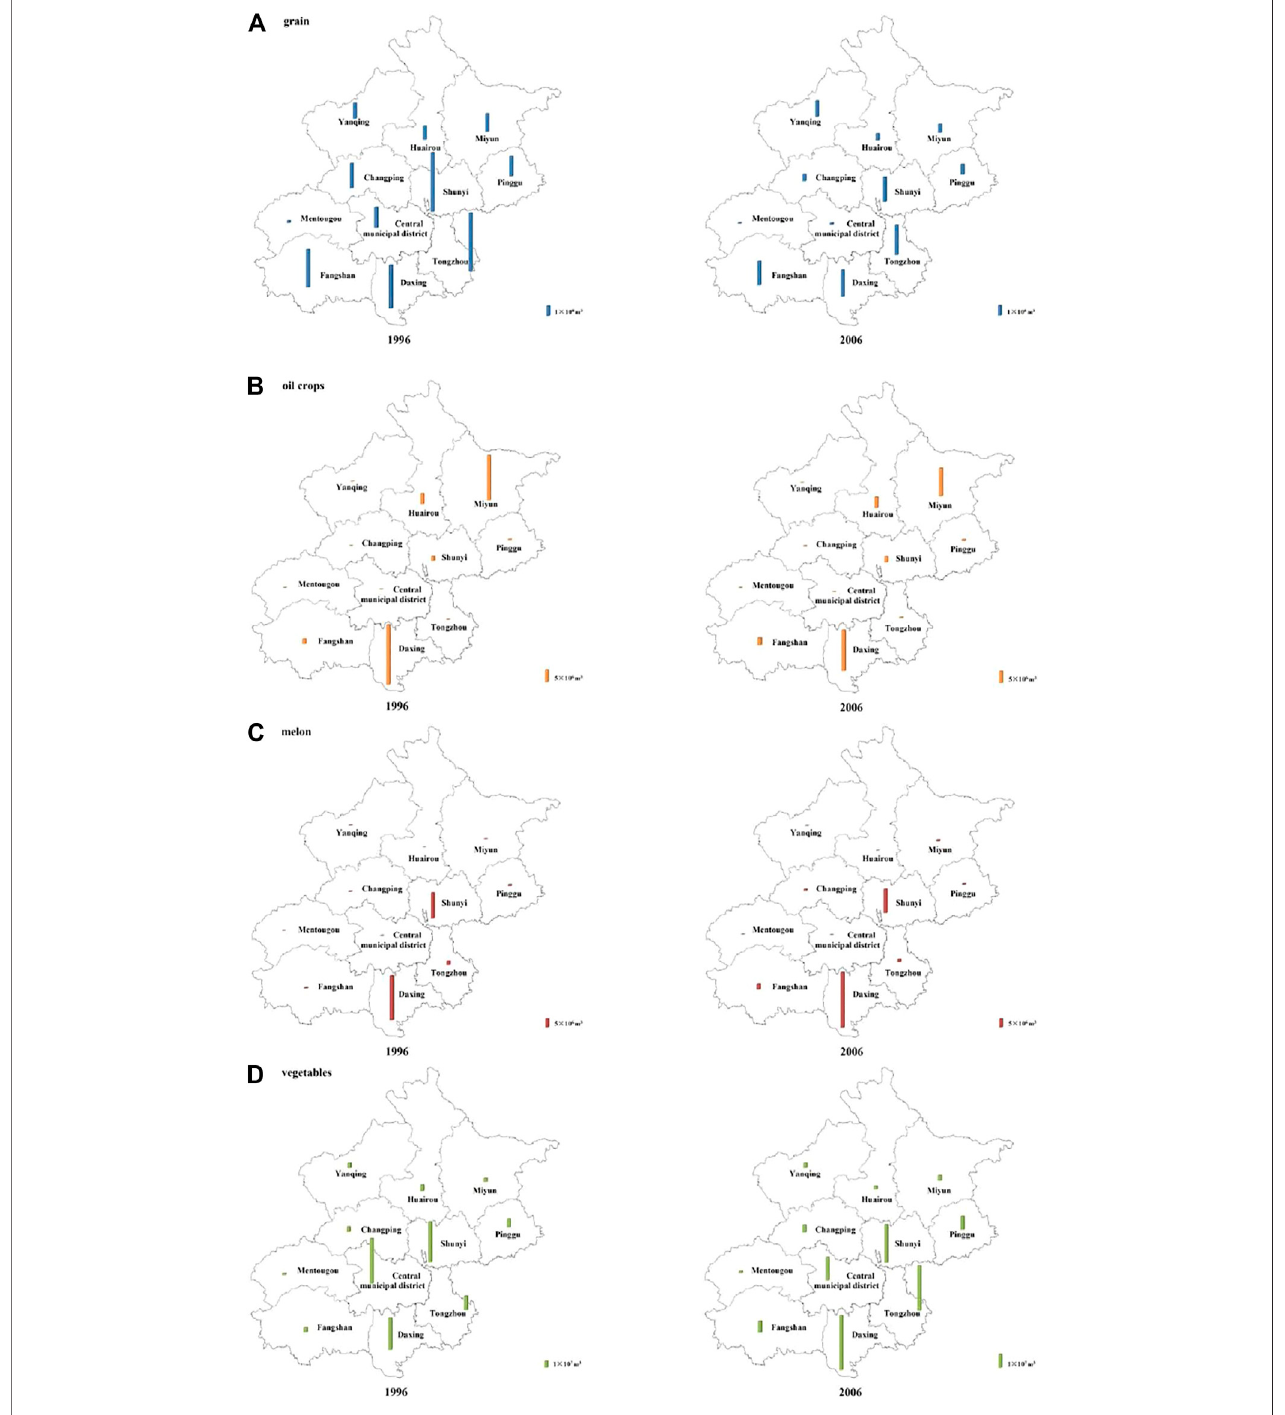
FIGURE 2 | The crop WF for districts and counties in Beijing in 1996 and 2006. Panel 2A – D show the spatial pattern of grain WF, oil crops WF, melon WF and vegetables WF respectively.